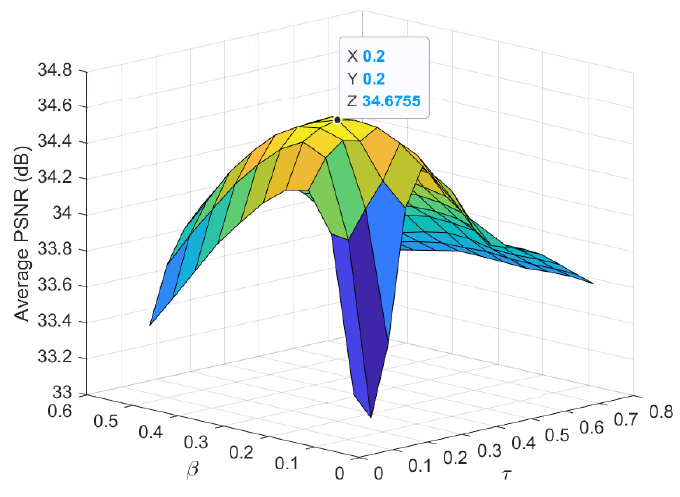
Figure 6. PSNR of the proposed clustered BCS according to τ and β when r = 0.5 and K =